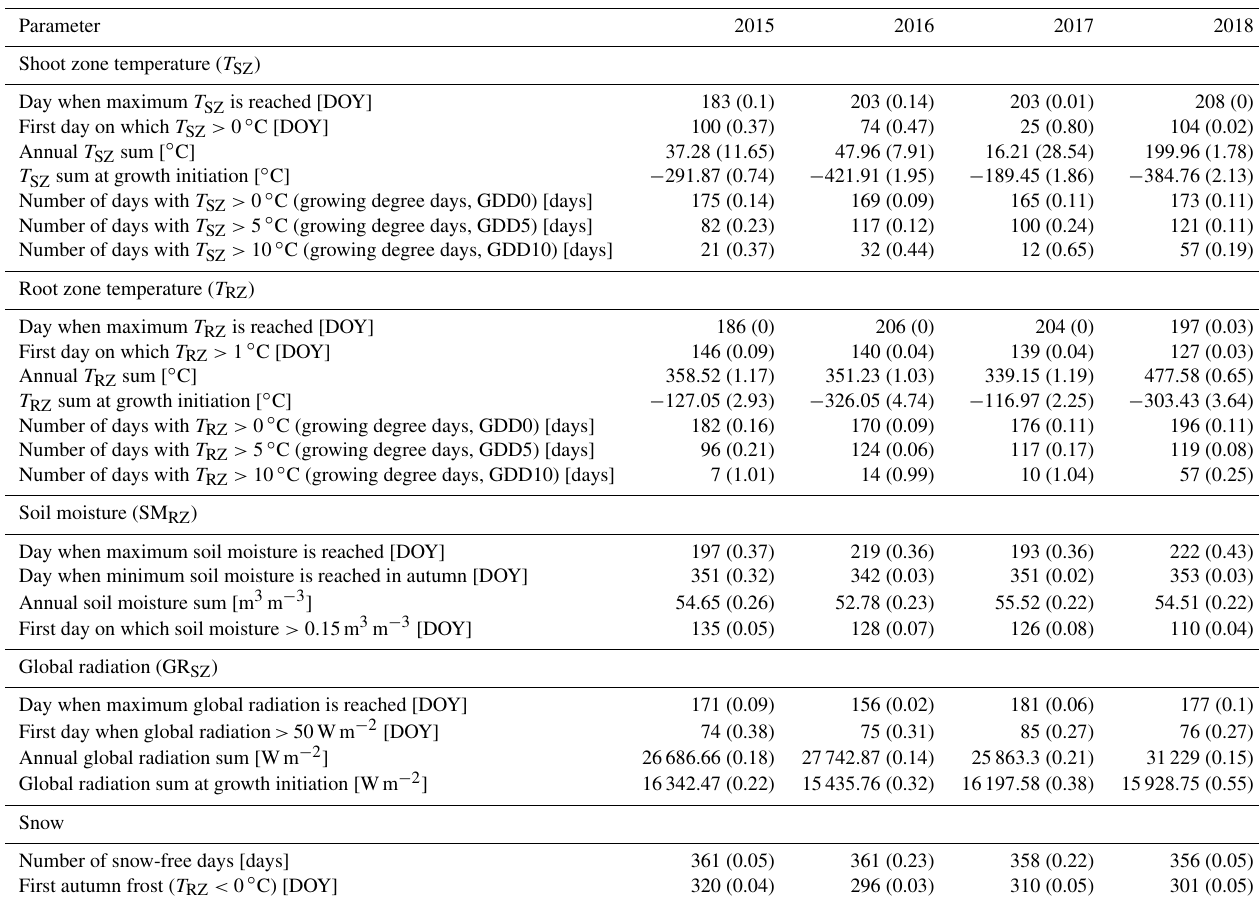
Table 1. Summary of calculated environmental parameters (means) for each year. Numbers in parentheses represent inter-site variability (coefficient of variation, CV).